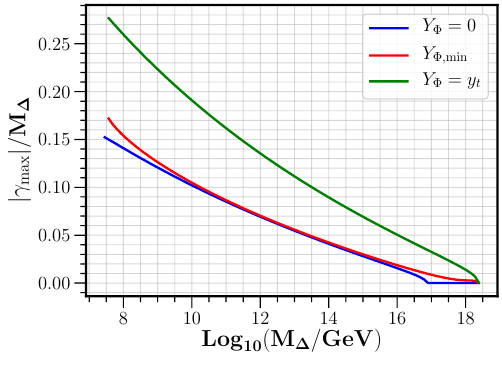
Figure 8 . Maximum bound on the cubic coupling | γ | by requiring vacuum stability below M ∆ , i.e. λ ( M ∆ ) > 0 , as a function of the triplet mass. In blue, red and green we respectively show the cases of Y Φ ( M ∆ ) = { 0 , Y Φ , min , y t } . The larger the Yukawa coupling Y Φ , the larger the maximum bound of | γ | . This is due to the fact that λ 3 grows faster with decreasing scale for larger Y Φ , see eq.